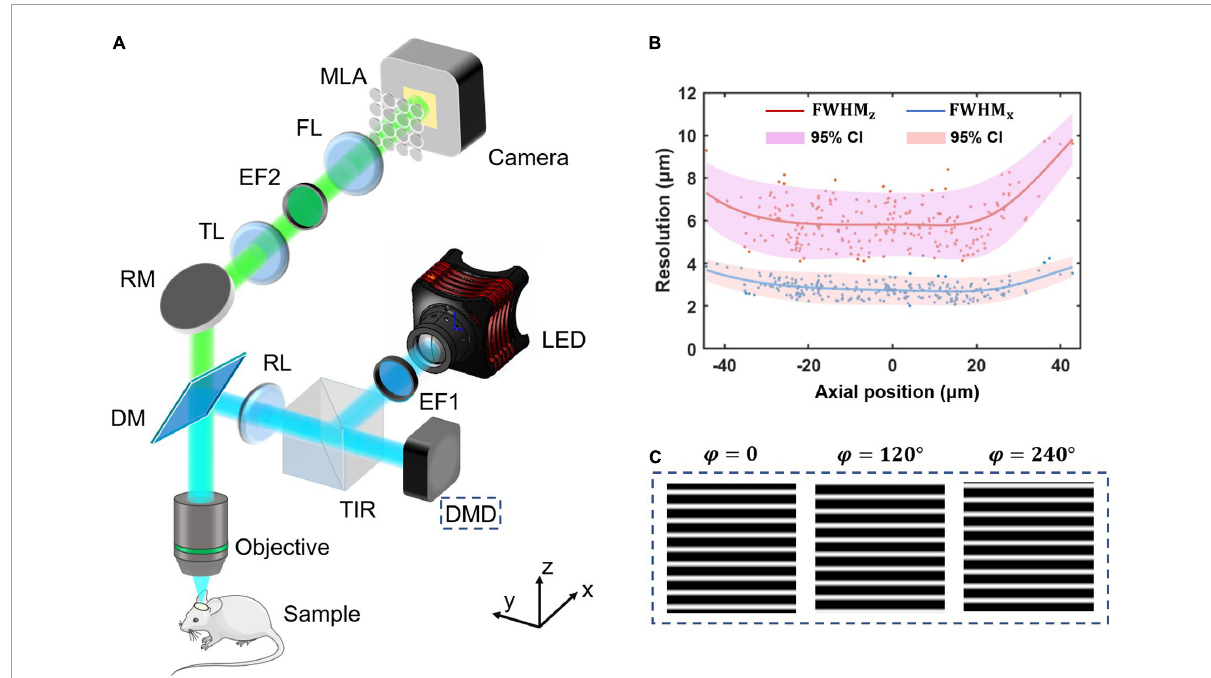
FIGURE1 The system design and resolution calibration of SI-FLFM. (A) Optical scheme of SI-FLFM. The digital micromirror device (DMD) plane is conjugated with the native objective plane (NOP), thus projects the structured patterns on the sample. EF1, excitation filter 1; DMD, digital micromirror device; TIR, total internal reflection prism; RL, relay lens; DM, dichroic mirror; RM, reflector mirror; TL, tube lens; EF2, emission filter 2; FL, Fourier lens; MLA: microlens array. (B) Three-dimensional resolution with 95% confidence interval (CI), fitted by LOESS algorithm. The resolution is calibrated by full-width-at-half-maximum (FWHM) of the imaging results of sub-resolution micro-beads ( (cid:56) = 1.1 µ m). (C) The generated sinusoidal patterns of different phases for illumination are loaded in the memory of DMD. The fringe period is 90 pixels, calculated based on the DOF of